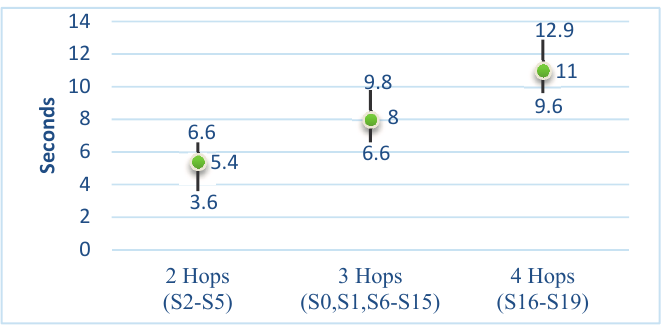
Figure 16. Latency intervals (within a 95% interval) of signals.